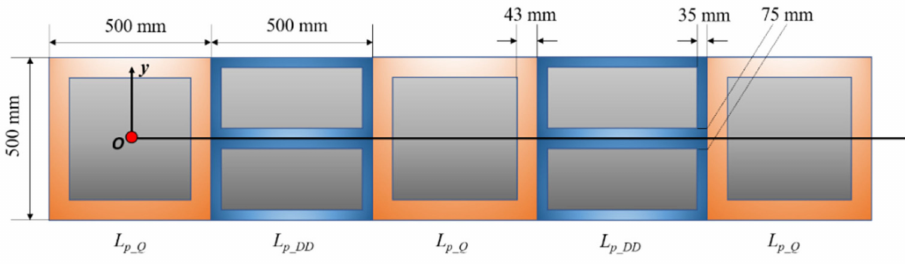
Figure 3. The detailed diagram of the transmitter array.